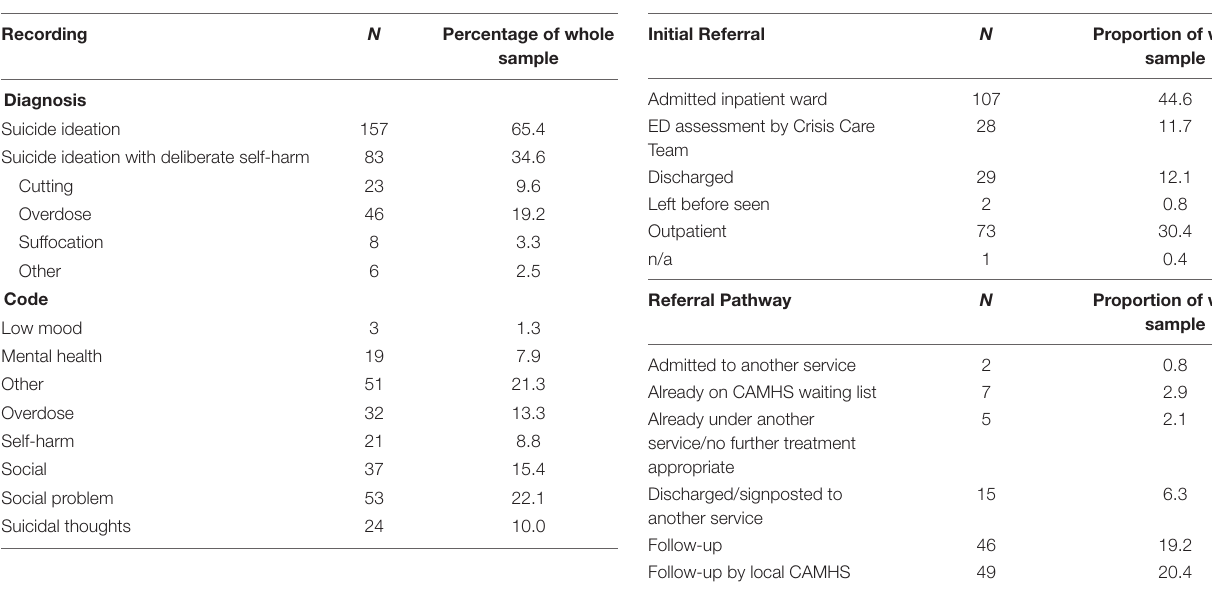
TABLE 4 | Diagnosis and coding frequencies for patients with suicidal crisis. TABLE 5 | Referral pathways for patients in ED with suicidal